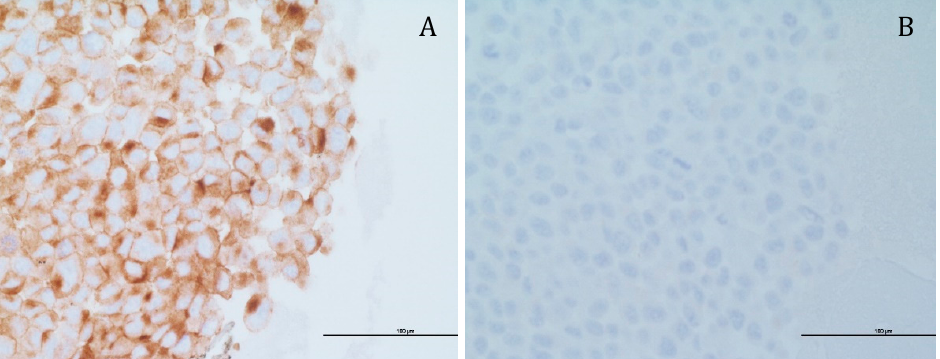
Figure 8. Immunohistochemistry analysis of PSMA expression. PSMA expression (shown as a brown diaminobenzidine immunohistochemistry staining) was examined in: ( A ) LNCaP; ( B ) PC-3 cell lines by the department of pathology in Rambam Health Care Campus. Scale bars denote 100 μ m.